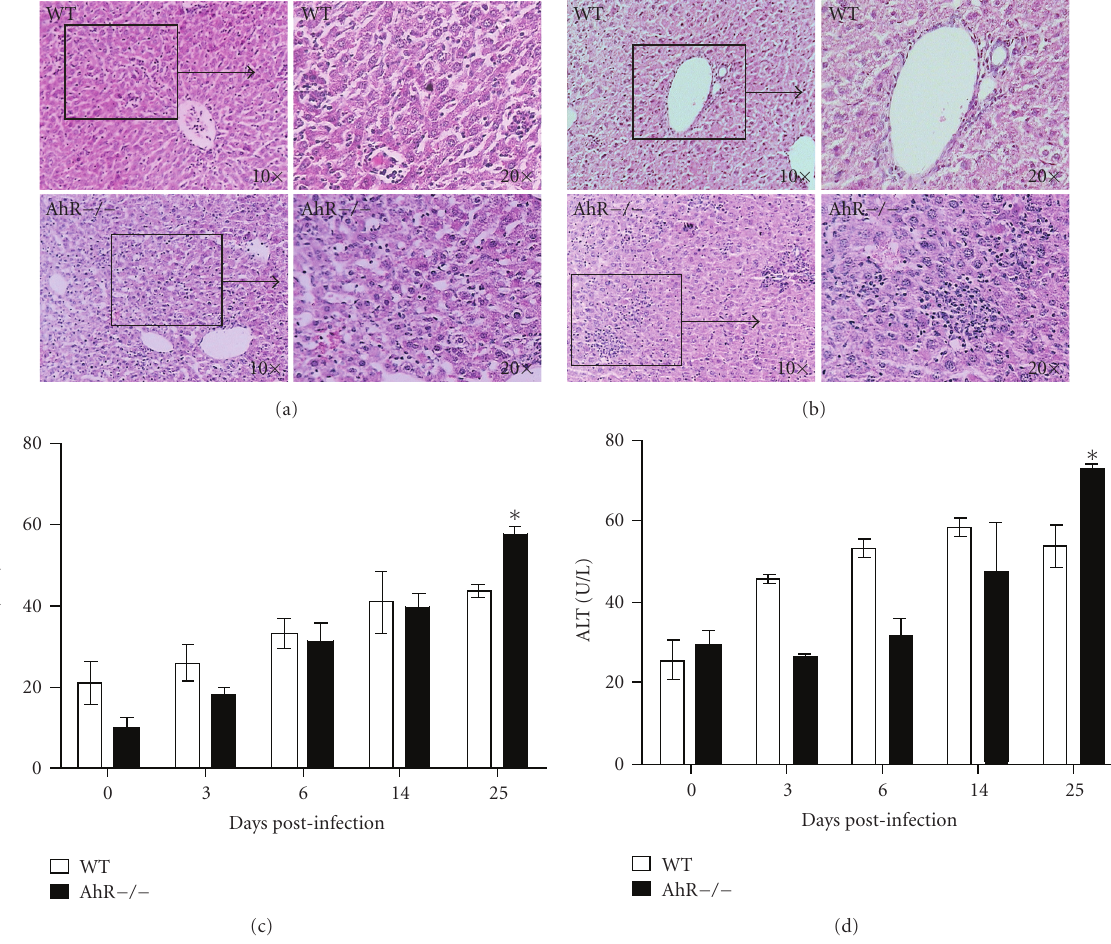
Figure 6: Representative histopathological liver changes after 10 days (a) or 25 days (b) of infection with 40 cysts of T. gondii . Note the mass of necrosis observed by H & E staining (arrow). (c) Serum transaminase levels on AhR-/- and WT infected mice. ∗ P < . 05, Student’s t